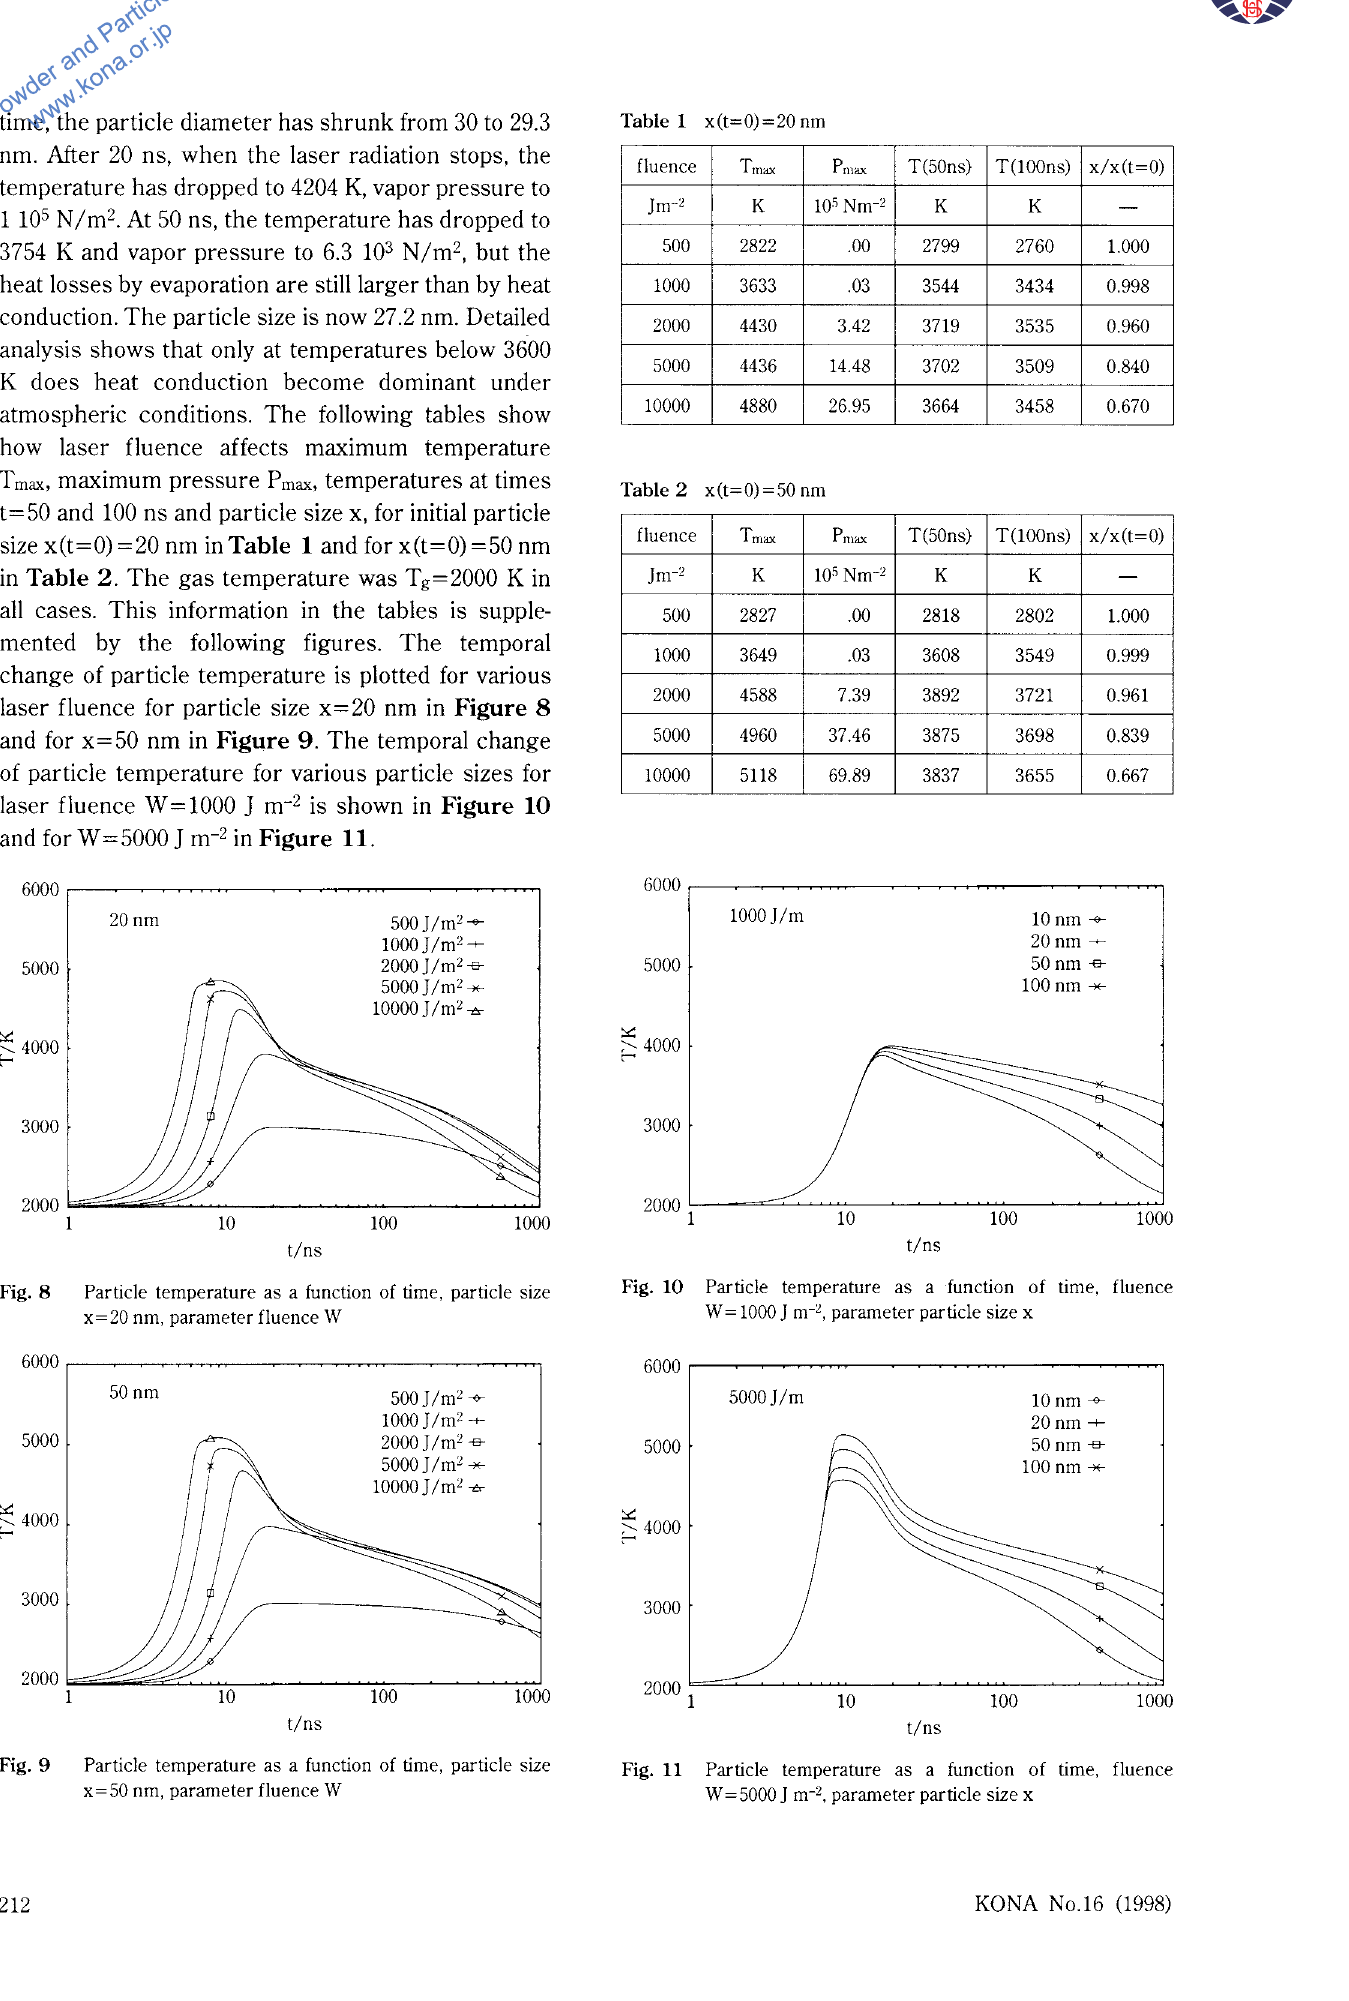
Fig. 11 Particle temperature as a function of time,